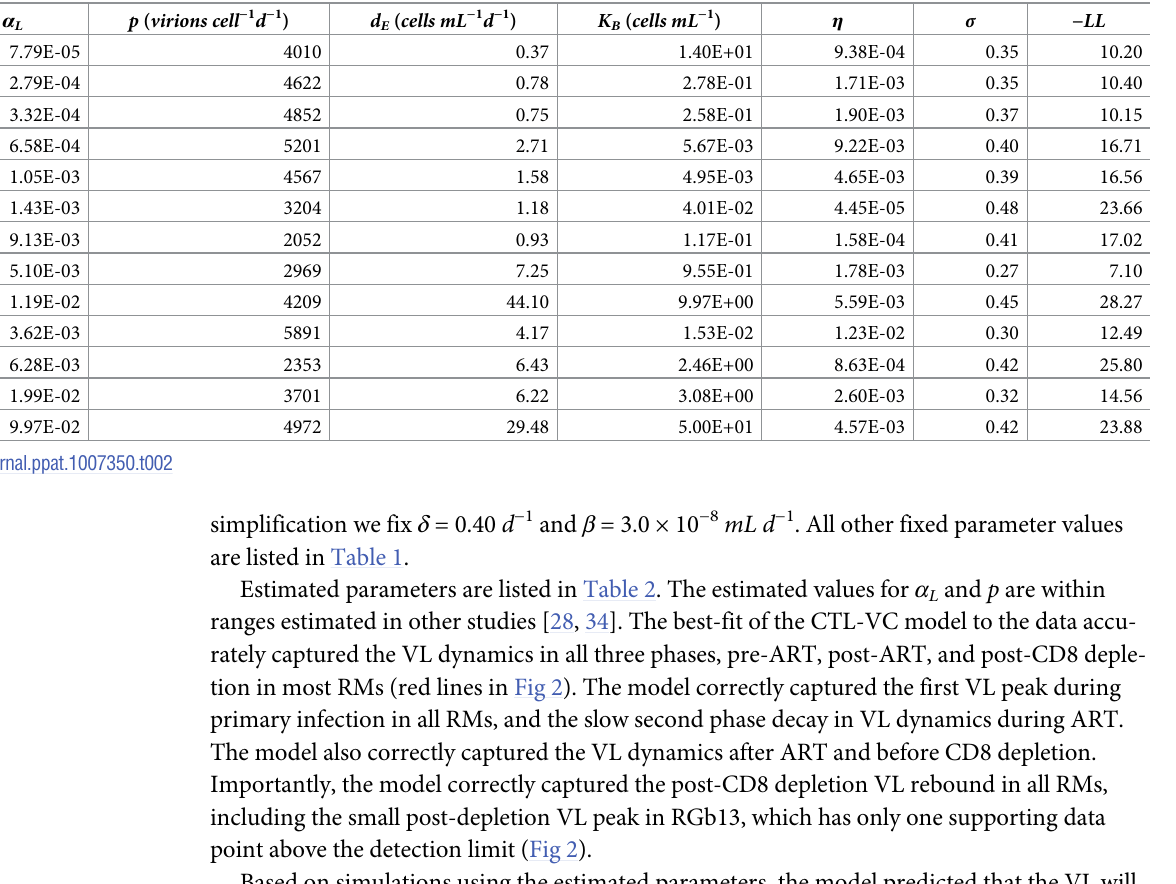
Table 2. Estimated parameter values for the CTL-VC